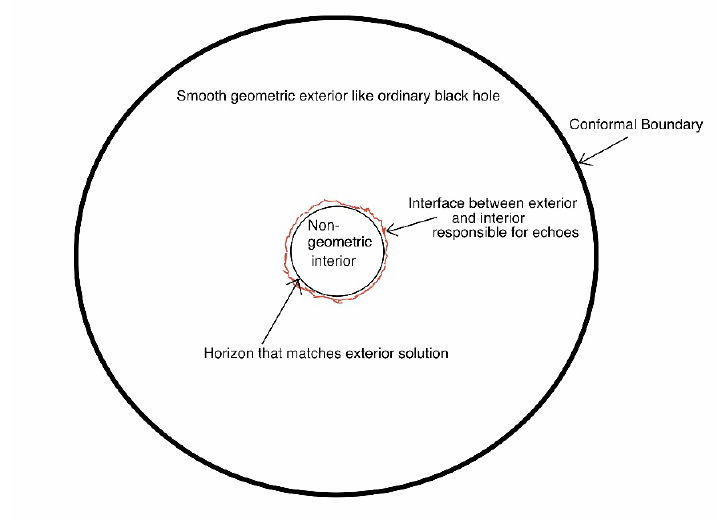
Figure 5 . A diagram depicting the bulk dual of a particular CFT state that exhibits echoes. The exterior far from the horizon resembles a standard black hole geometry. Within a Planck length of the horizon one expects the smooth geometrical description of spacetime to breakdown at the jagged surface colored in red. E(cid:11)ectively the interface between the smooth exterior and non-geometric interior generates